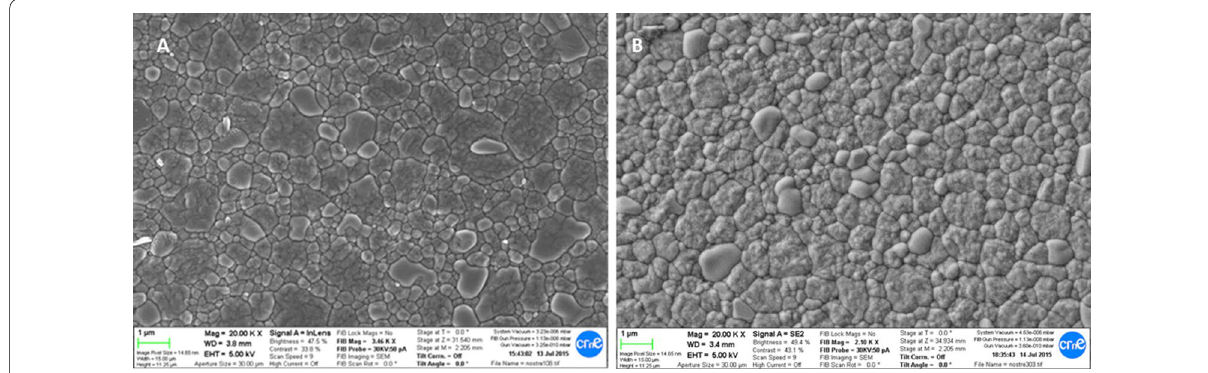
Fig. 2 Microstructure of zircona observed by scanning electron microsocopy. A Dental implant. B Femoral